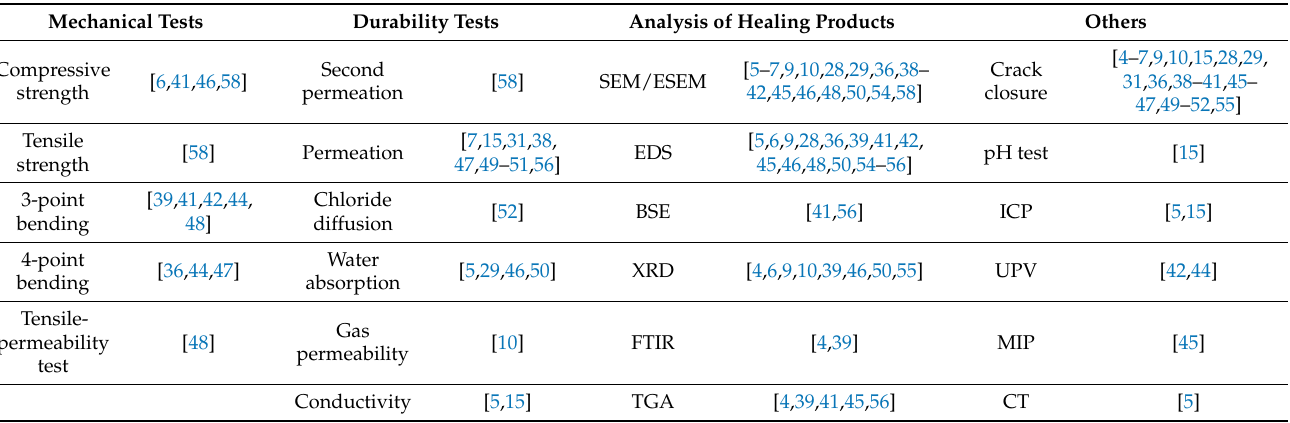
Table 5. Healing ability